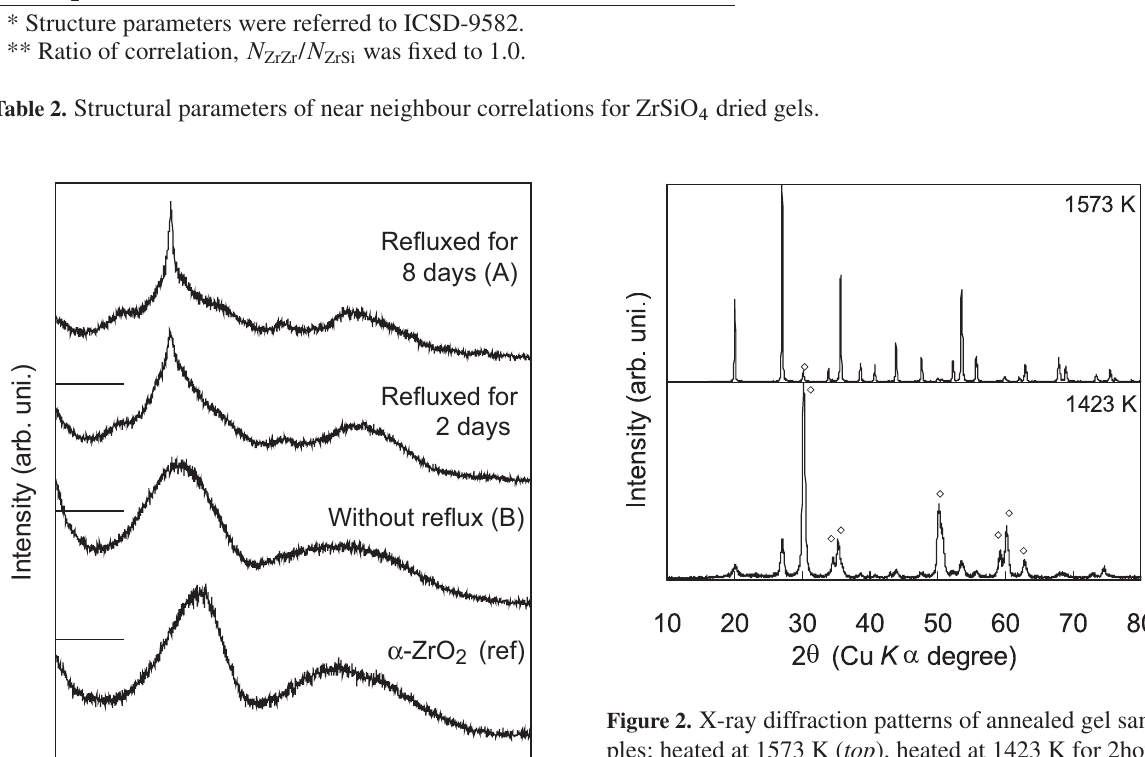
Figure 2. X-ray diffraction patterns of annealed gel sam- ples; heated at 1573 K ( top ), heated at 1423 K for 2hours ( bottom ). (cid:2) D tetragonal-ZrO 2